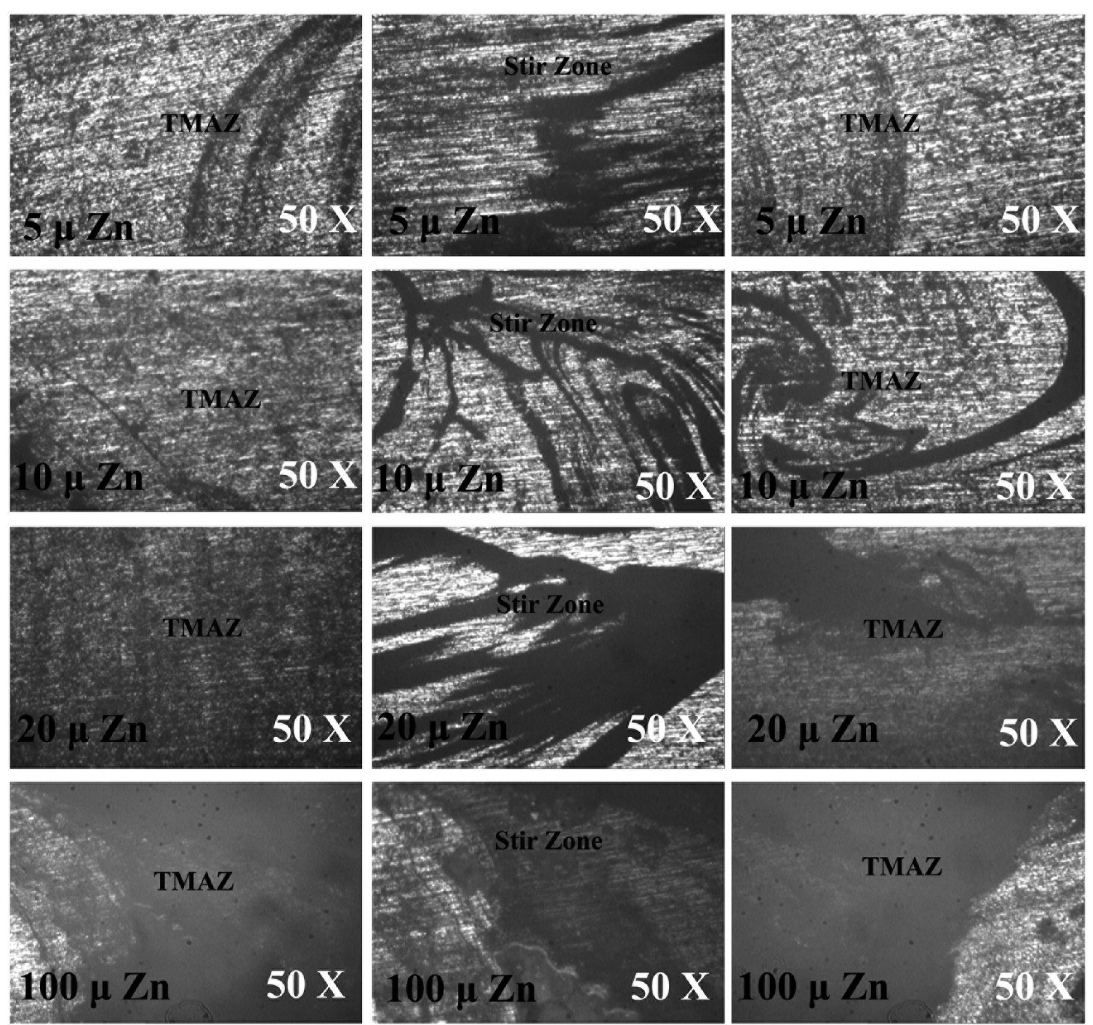
Figure 7: Micro view of joints with the various Zn interlayer. variation in thermal conductivity and a melting point between interlayer (Zn) and parent metal (Al); so while solidification Zn dissipates more energy and shrink first and yields Intergranular fracture. This shows if the interlayer thickness is further increased leads poor metal distribution and